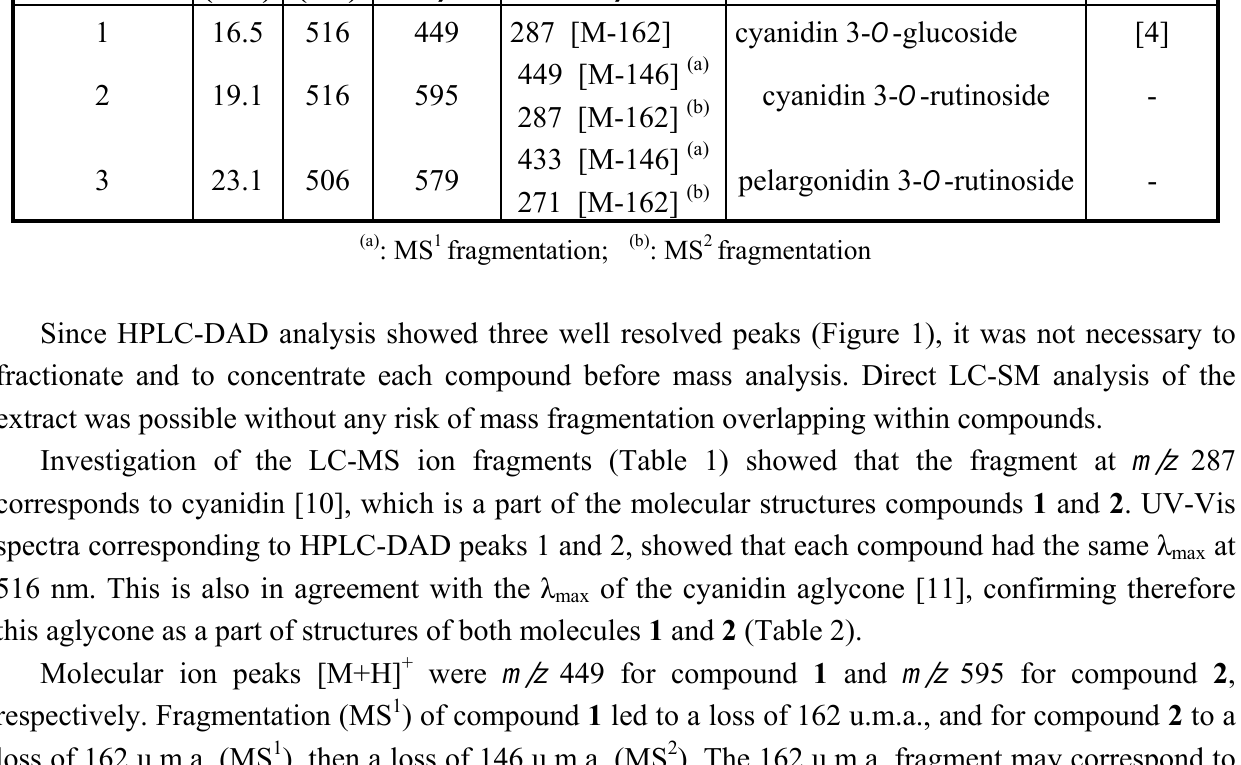
Table 1. HPLC-DAD and LC-MS data obtained from the analysis of Delonix regia flower extracts. HPLC